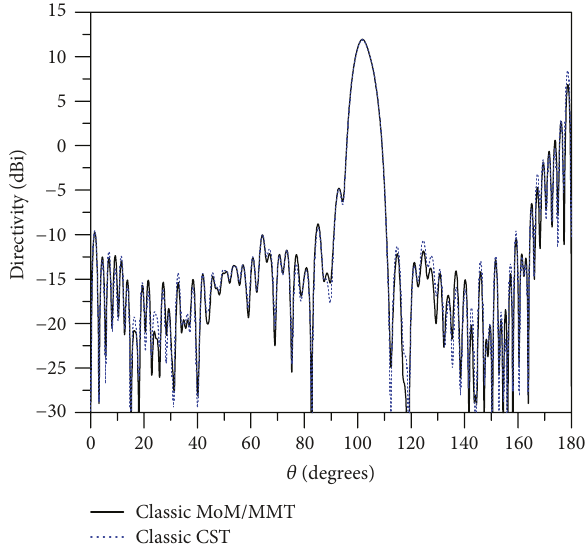
Figure 10: MoM/MMT and CST radiation patterns of the classical and shaped ADE antenna.